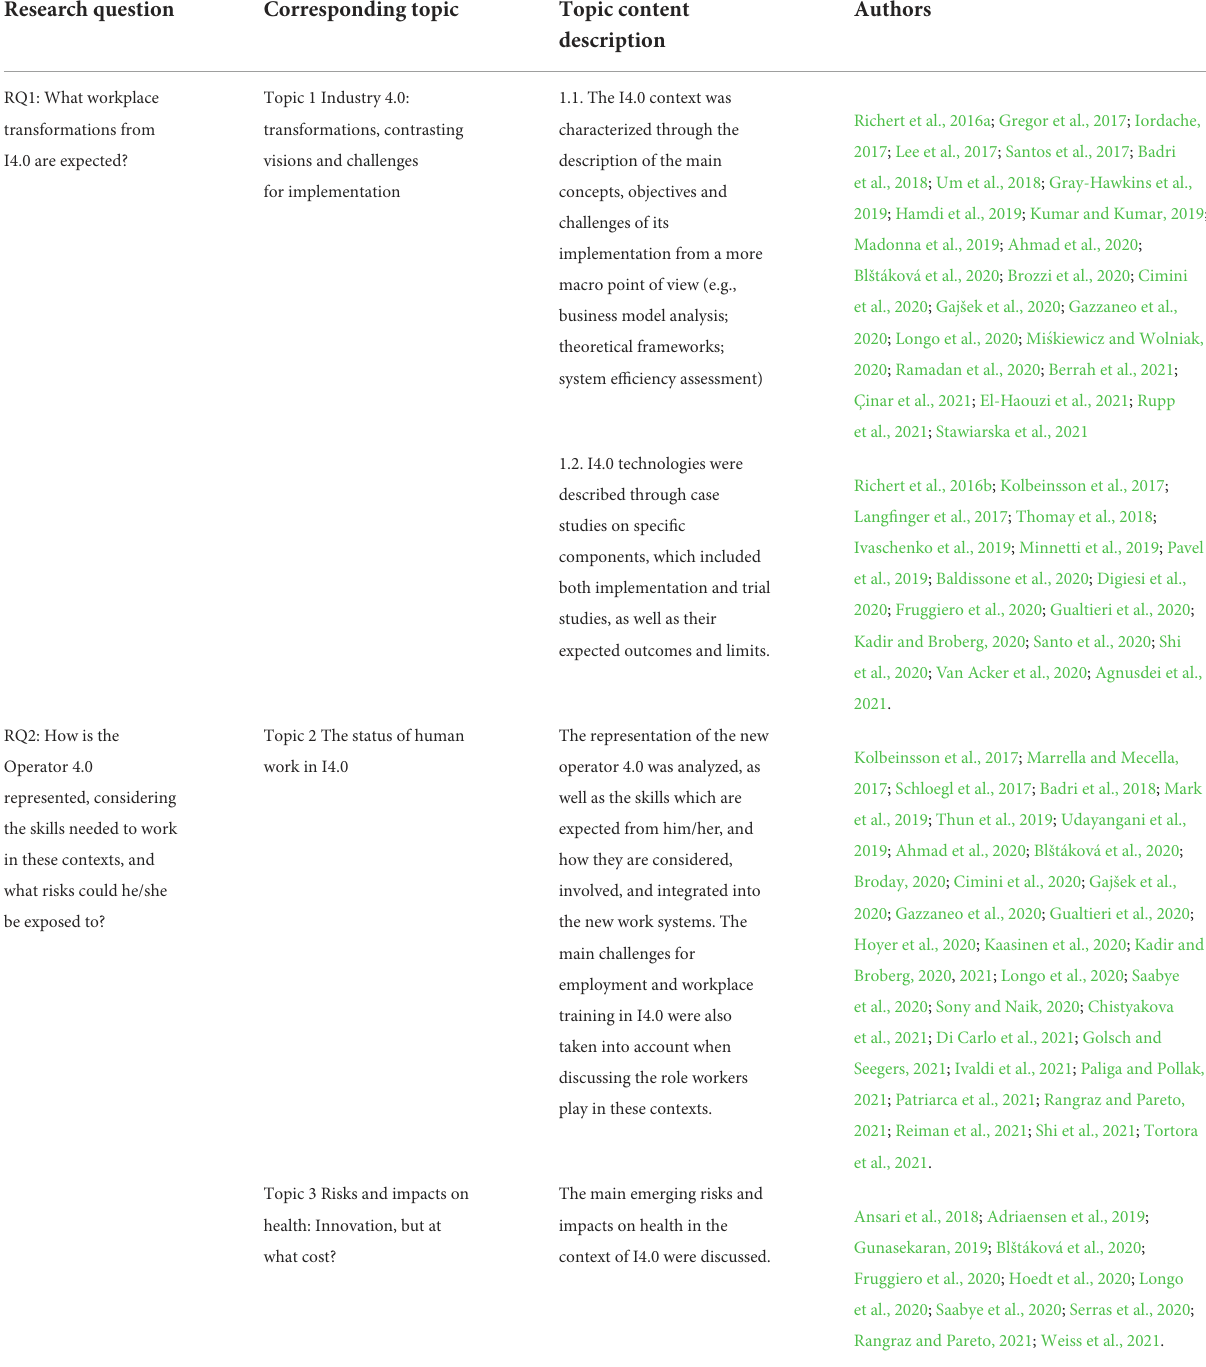
TABLE 2 Distribution of the selected articles according to the research